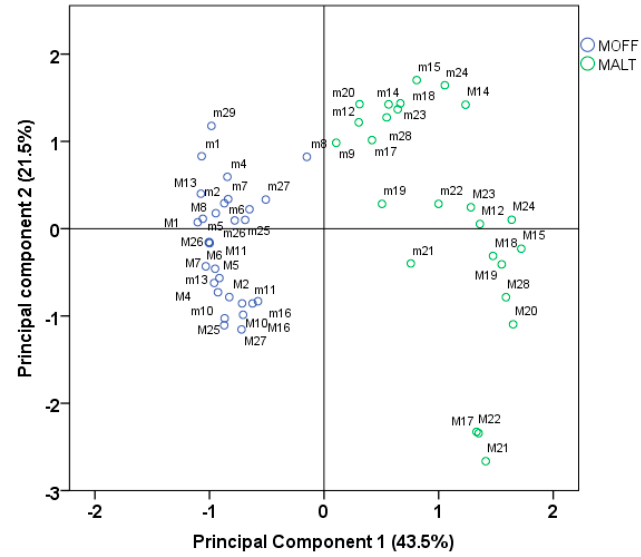
Figure 2. Projection of Melissa officinalis accessions onto the plane of two main PCA factors obtained